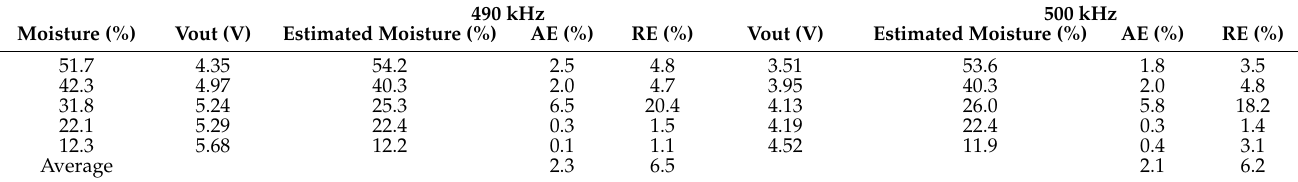
Table 13. Verification NP2, 490 kHz, and 500 kHz two